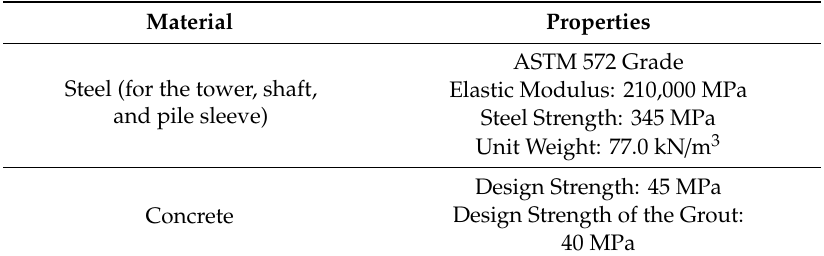
Figure 5. Dimensions of the CCSS. Table 2. Material